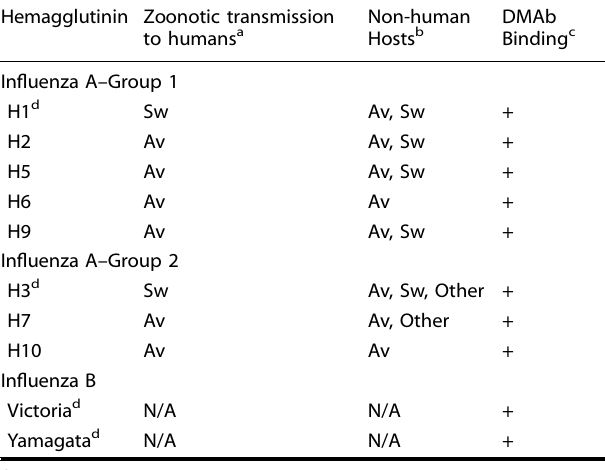
Table 1. Serum DMAbs bind to hemagglutinin antigens from in fl uenza virus subtypes known to cause disease in humans Hemagglutinin Zoonotic transmission to humans